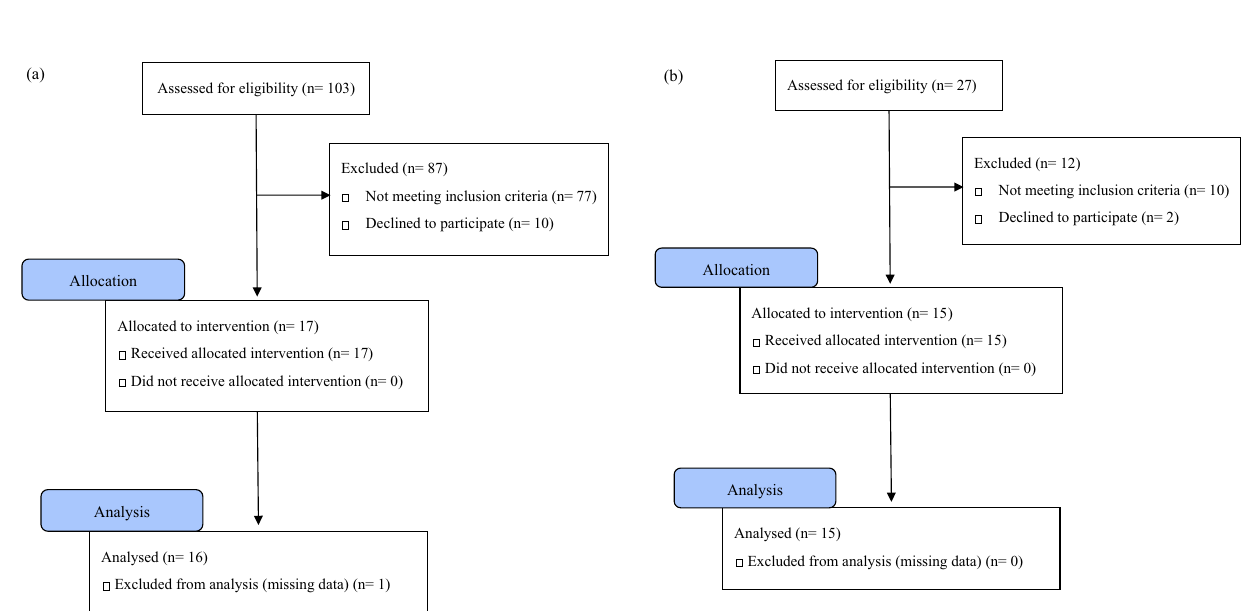
Figure 2. Flow diagram of participants. ( a ) Chronic pain patients, ( b ) healthy volunteers with no